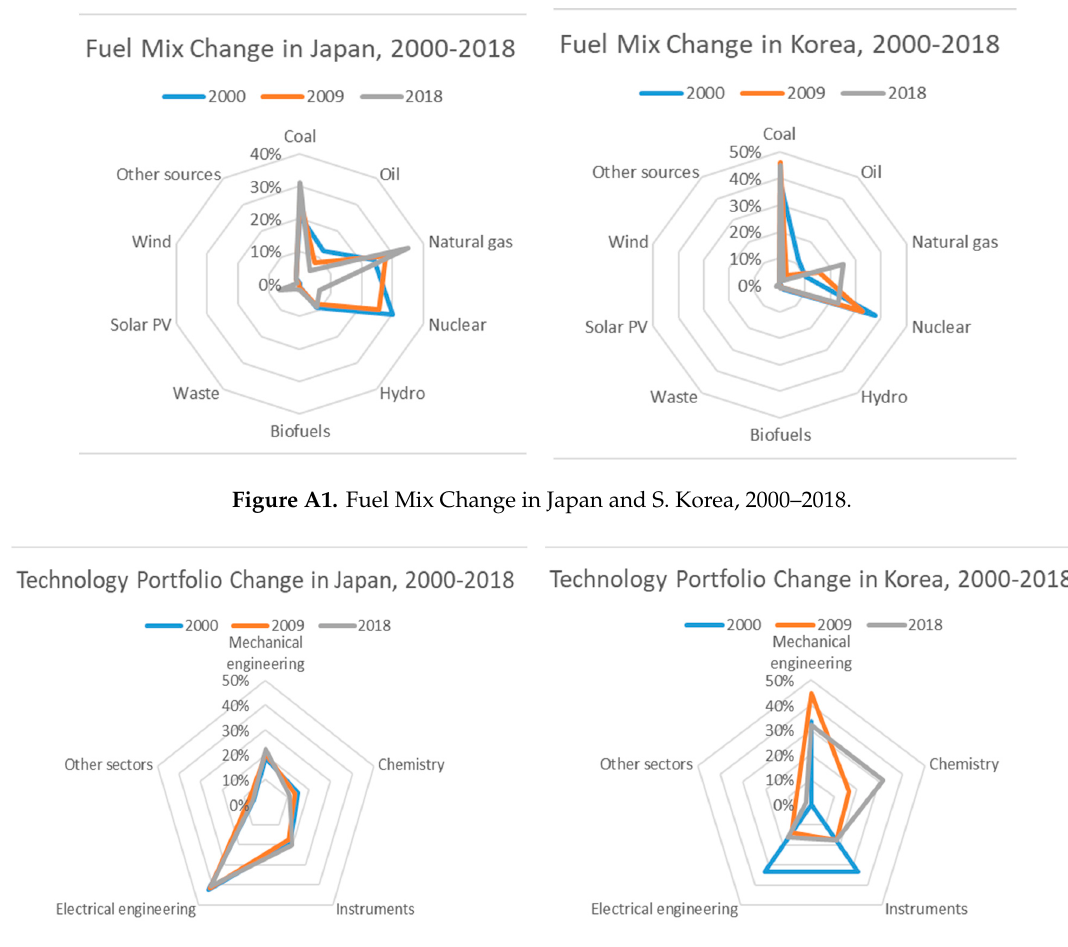
Figure A2. Technology Portfolio Change in Japan and S. Korea, 2000–2018.